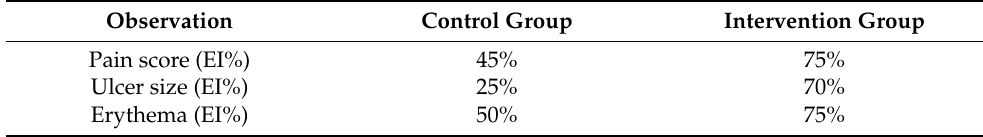
Table 5. Efficacy incidences of the intervention group at the end of treatment.